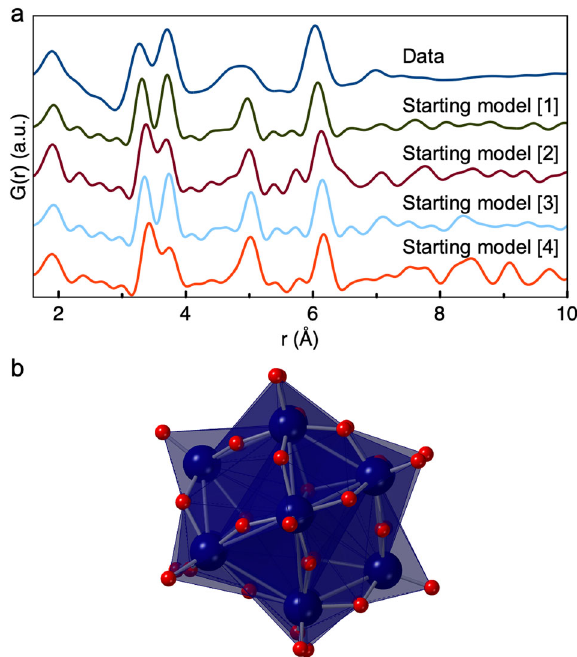
Fig. 8 Experimental PDF from Keggin clusters in solution. a Comparison of experimental data from a 0.05 M ammonium metatungstate hydrate solution, and simulated PDFs from the four different starting models [1] – [4] . The simulation parameters mimic typical values of a PDF dataset and can be seen in Supplementary Table 3. b The W 12 O 40 α -Keggin